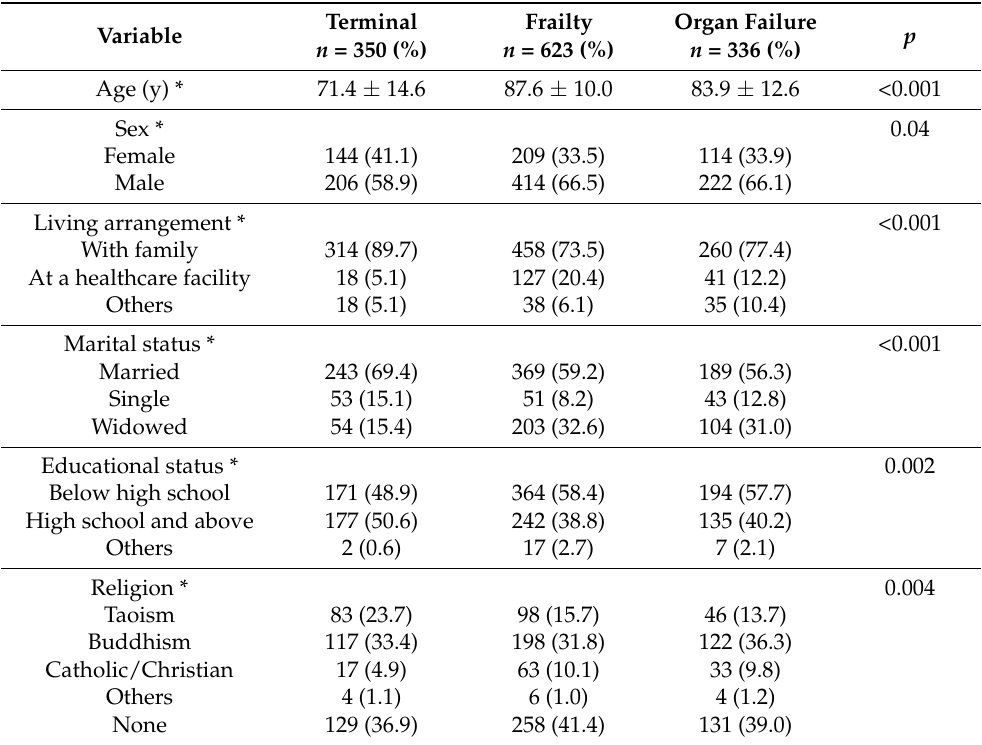
Table 1. Comparison of different end-of-life trajectories by patient sociodemographic